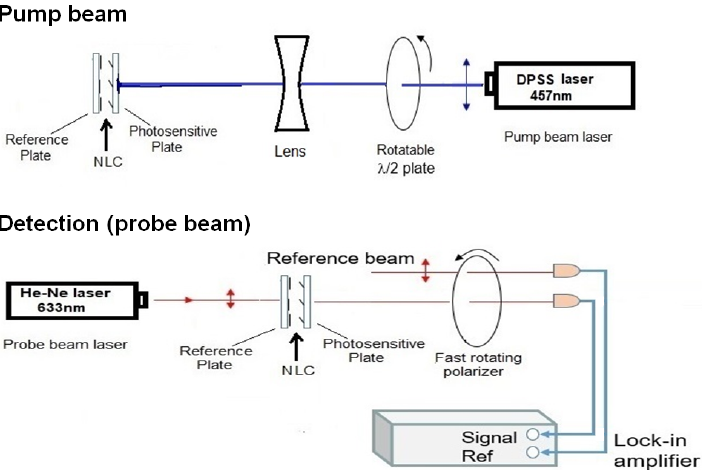
Figure 2. Experimental setup based on pump-probe beam technique, combined with a lock-in